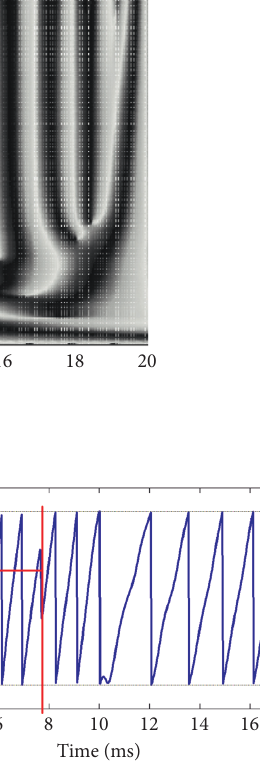
Figure 7: Time-phase angle curve with the frequency of 810Hz. Figure 8: Time-phase angle curve with the frequency of